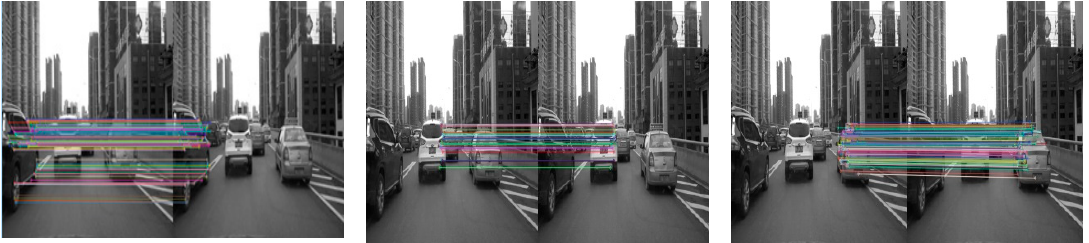
Figure 4. Extraction of feature points of different front vehicles.